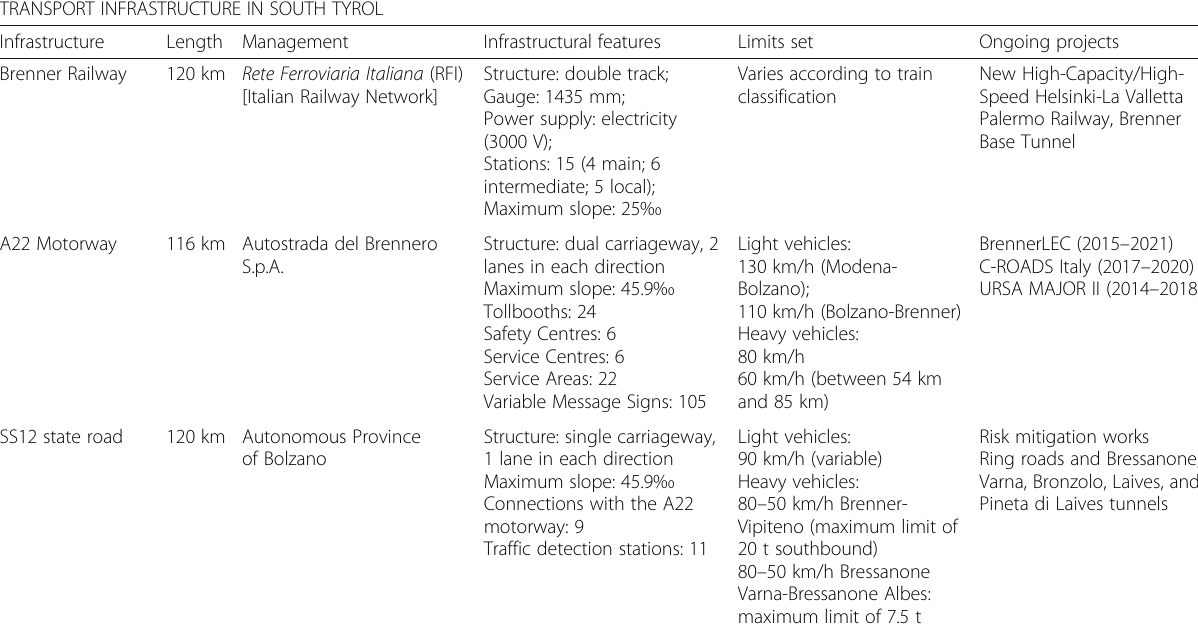
Table 1 Main infrastructures constituting the Brenner